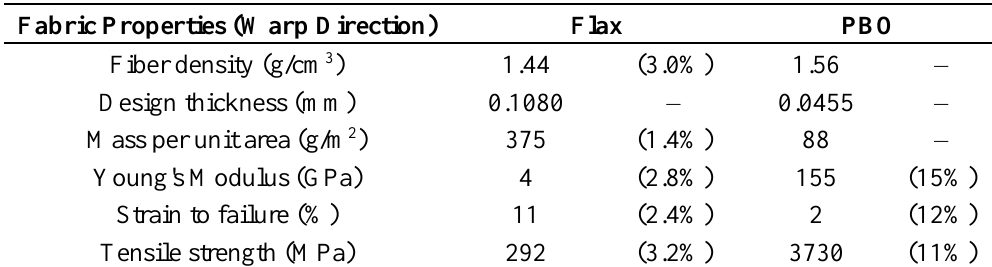
Figure 2. Reinforcing fabrics: ( a ) Flax fabric; ( b ) Strip of PBO fabric. Table 2. Properties of the reinforcing